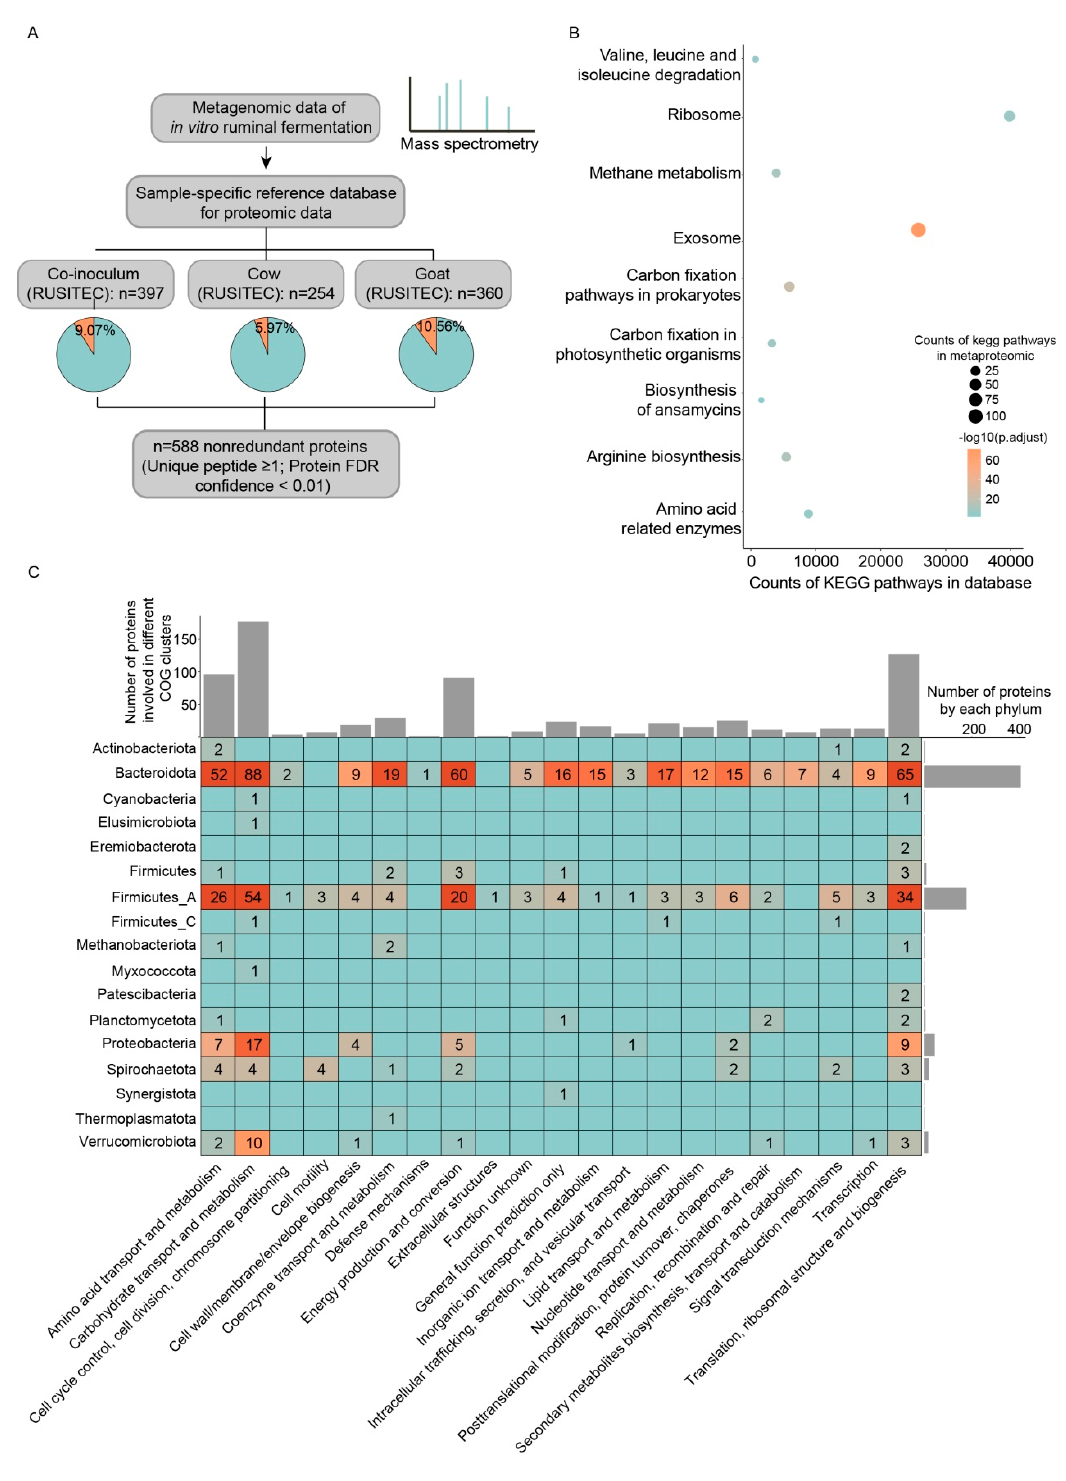
Figure 2. Metaproteomic characterization of total microbial proteins under the conditions of in vitro ruminal fermentation. ( A ) Metaproteomic data analysis pipeline and the number of proteins identified from three different samples. ( B ) The overrepresented Kyoto Encyclopedia of Genes and Genomes (KEGG) pathways of identified proteins compared with the total proteins in the database. ( C ) Distribution of identified proteins in different clusters of orthologous groups (COG) and different microbial taxa.